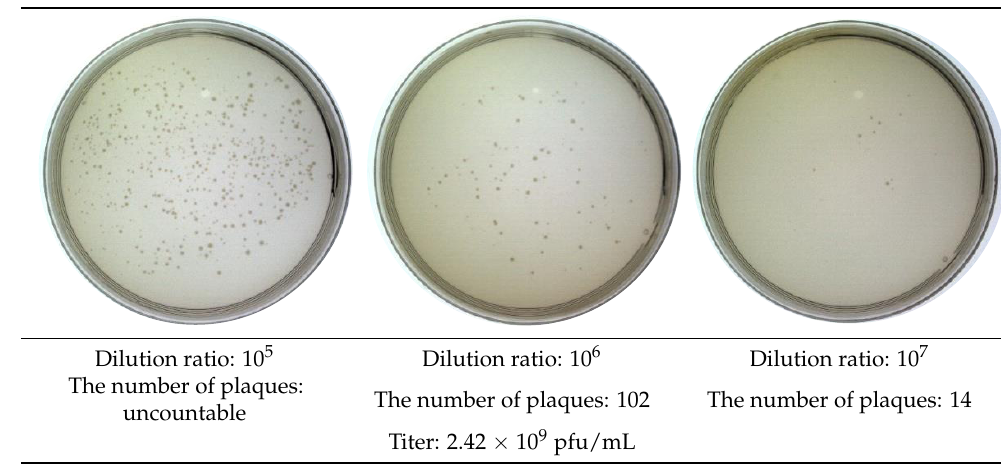
Table 2. Variance contribution percentage for PCs from 3DFS.